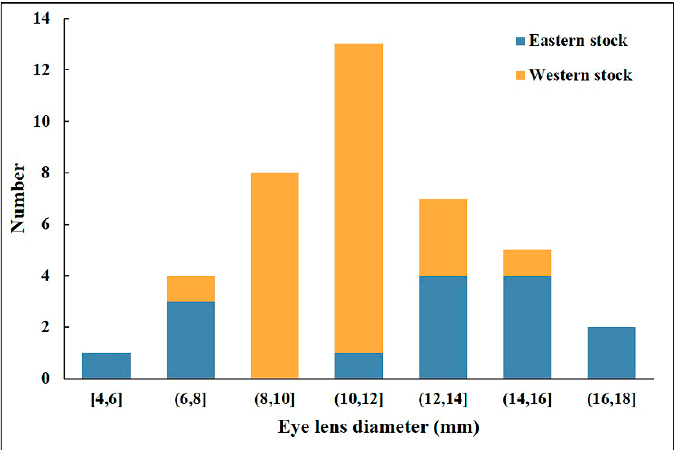
Figure 3. Details of the distribution of eye lens diameters for the eastern and western stocks of O. bartramii .